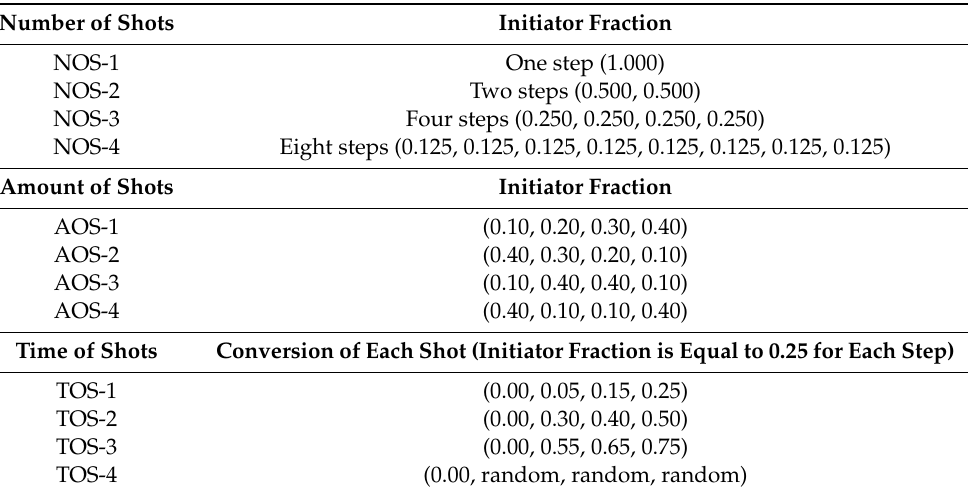
Table 3. Initiator feeding policy configurations with the same total amount of